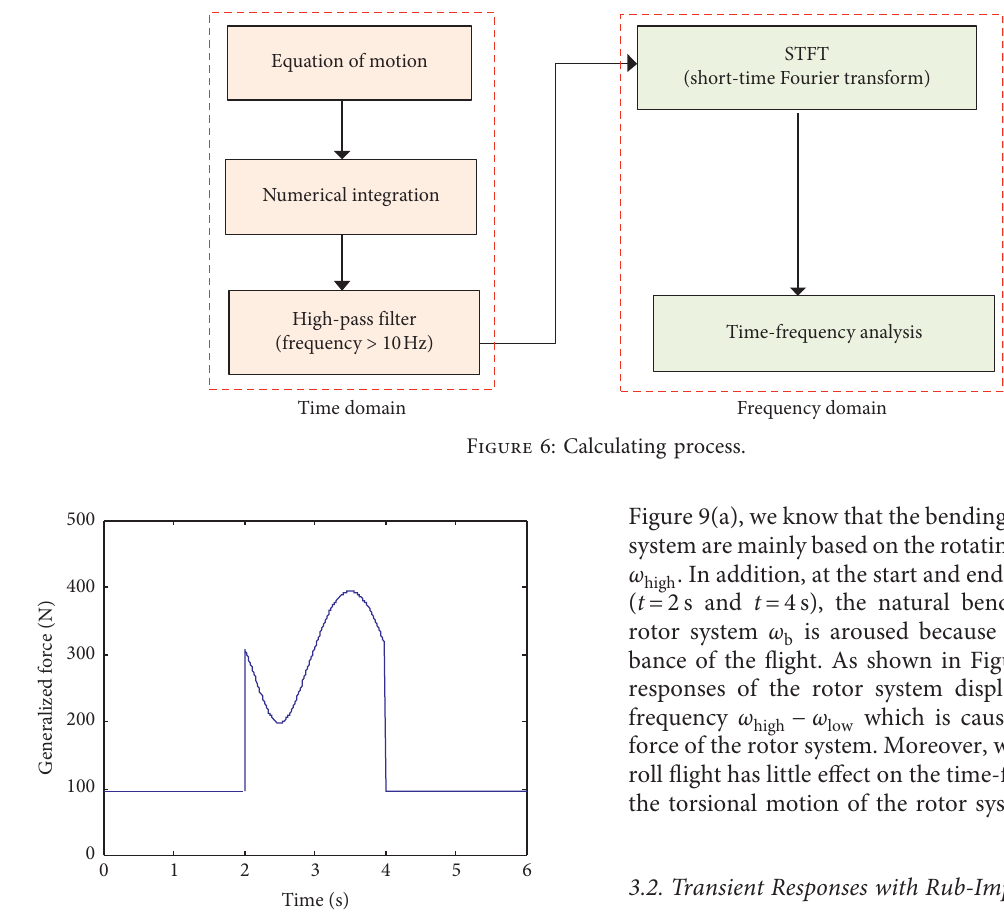
Figure 7: Generalized resultant force of the maneuver load and gravity applied to the disk m 2 .